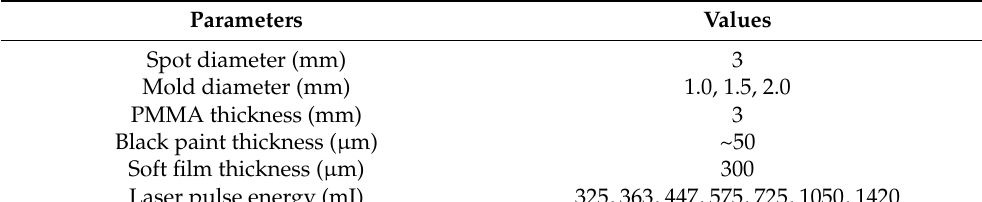
Table 4. Related experimental parameters.